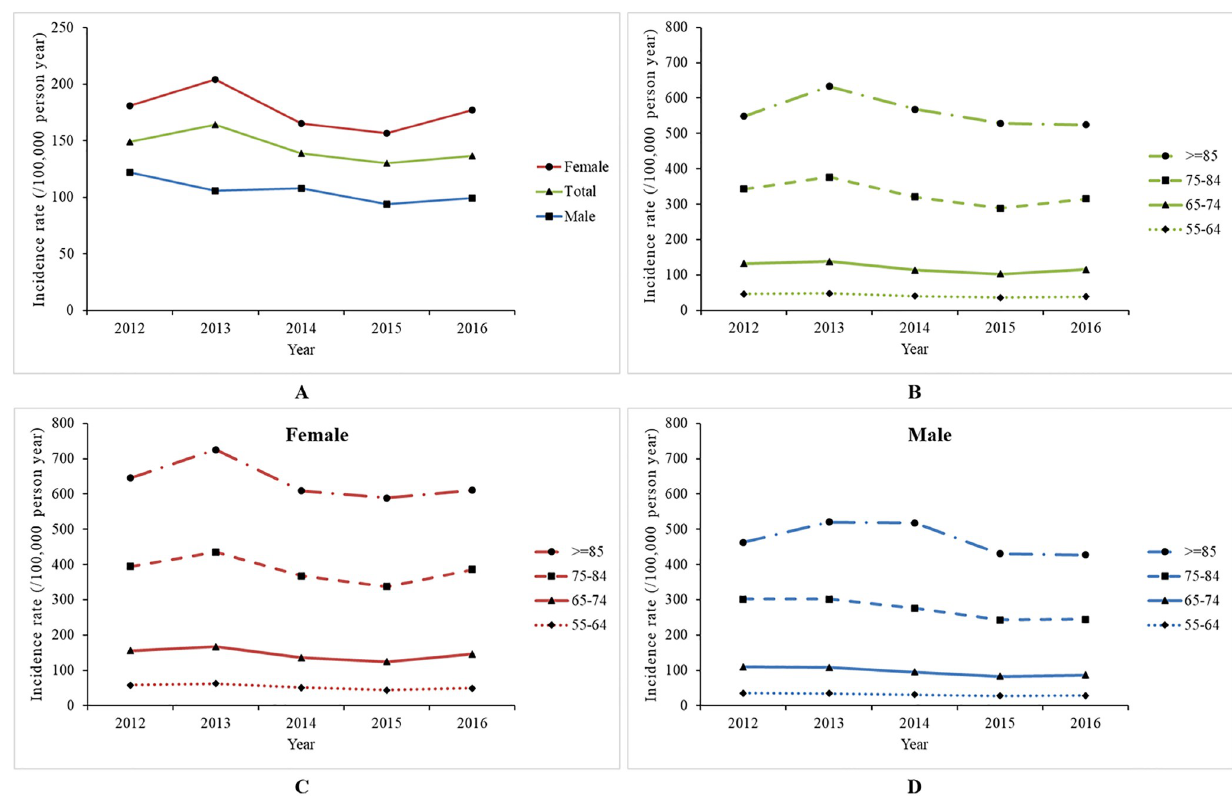
Fig 2. Crude incidence of hip fracture in the population grouped by sex, age, and sex–age group (per 100,000 person-years). (A) Hip fracture incidence by sex and year. (B) Age-specific hip fracture incidence. (C) Age-specific hip fracture incidence for females. (D) Age-specific hip fracture incidence for